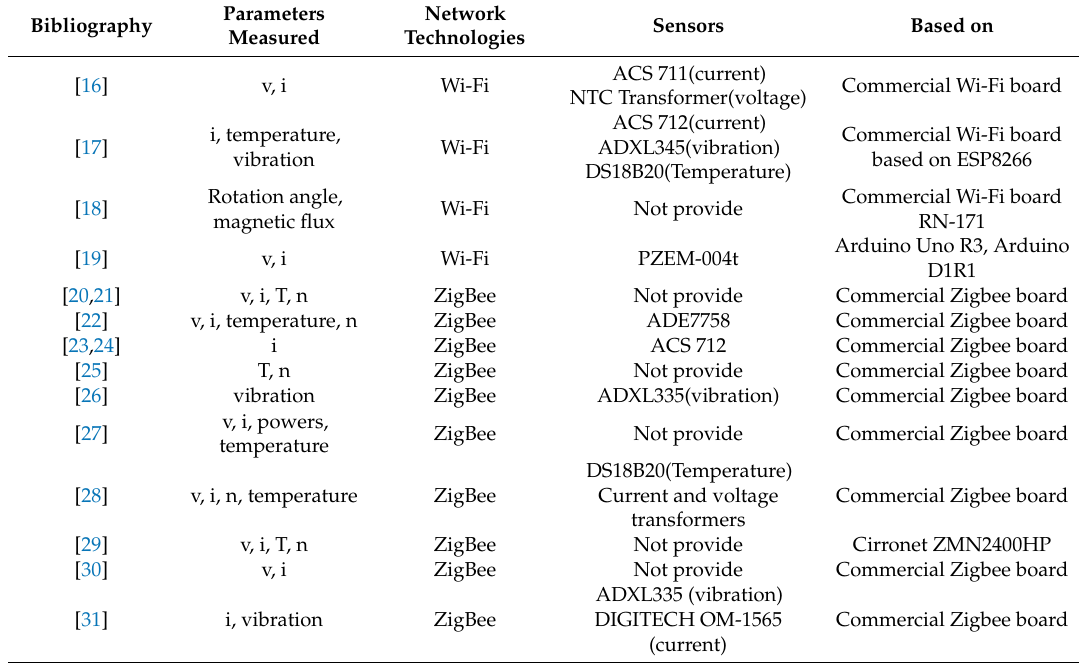
Table 1. Analysis of wireless technologies used in IMs